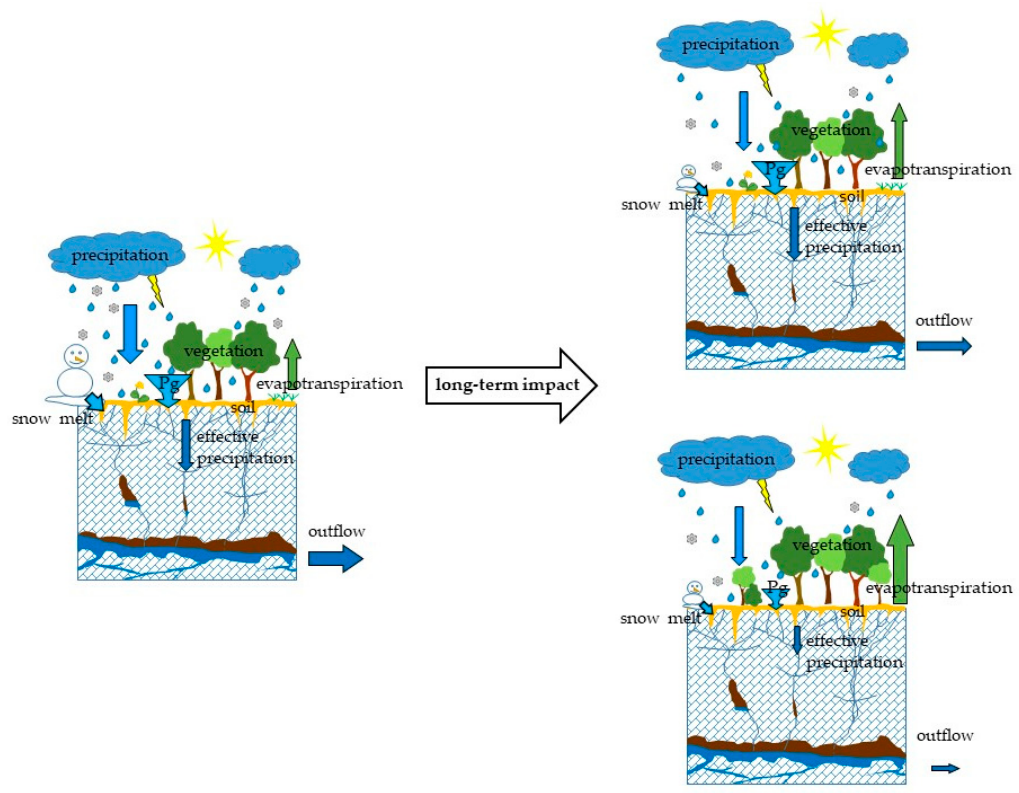
Figure 7. Conceptual model of long-term changes in the annual values of water balance elements in the case of insignificant natural vegetation overgrowth, but only climate variability (sketch top right) and in the case of significant natural vegetation overgrowth in addition to climate variability (sketch bottom right). The change in an arrow size illustrates the relative change in the respective parameter.